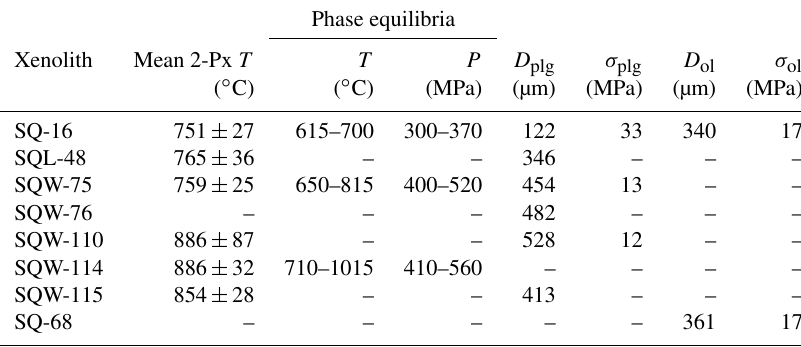
Table 1. Equilibration temperature and pressure, grain size, and differential stress. Phase equilibria Xenolith Mean 2-Px T